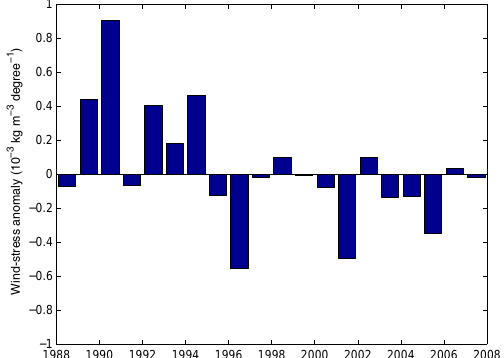
Figure 8. The wind forcing metric, expressed in units of northward density gradient (10 − 2 kgm − 3 ◦− 1 , regressed in the latitude range 48–62 ◦ N) – see text for details.